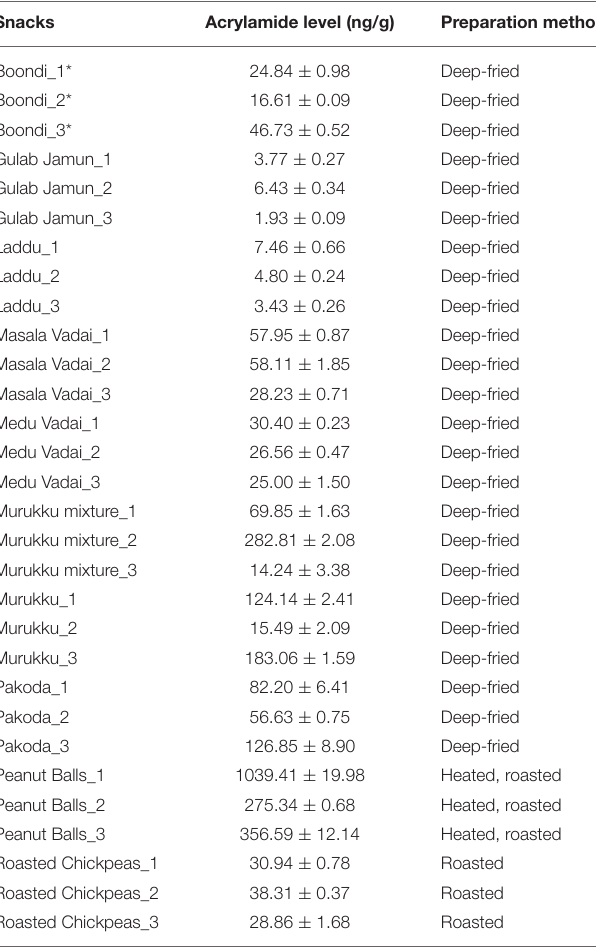
TABLE 4 | Acrylamide levels (ng/g) in commonly consumed local Indian snacks with three replicates.